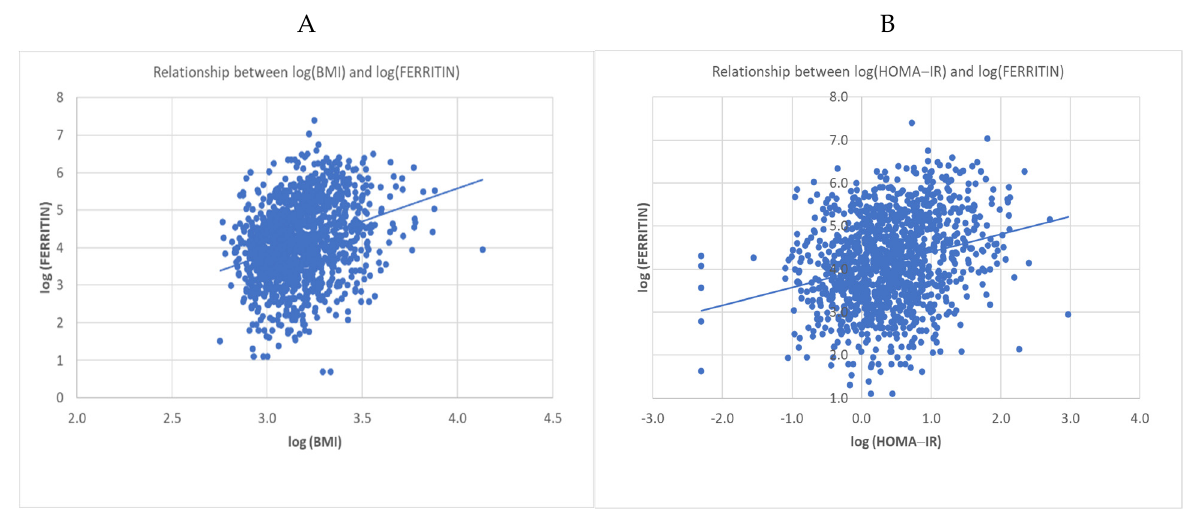
Figure 3. ( A ) Scatter plot of ferritin vs. body mass index (BMI), both on the logarithmic scale (Pearson’s correlation = 0.30; p < 0.0001; n = 1311). ( B ) Scatter plot of ferritin vs. homeostatic model assessment ‐ insulin resistance (HOMA ‐ IR), both on the logarithmic scale (Pearson’s correlation = 0.26; p < 0.0001; n = 1241).